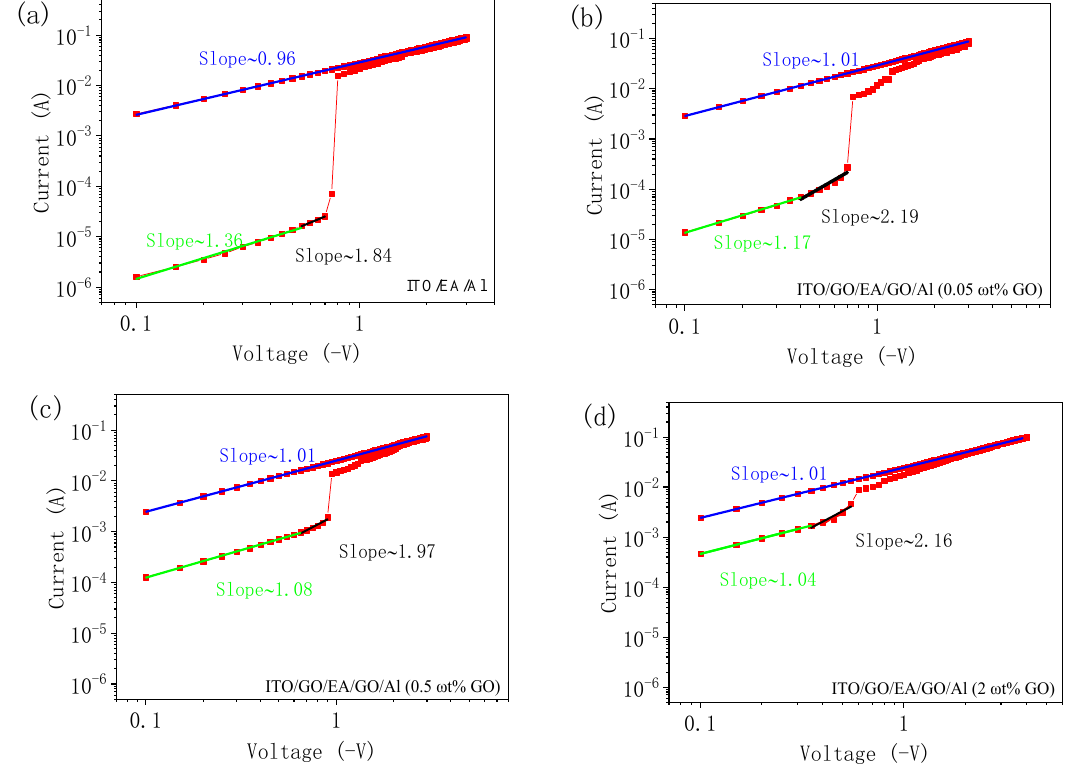
Figure 13. Cumulative probability of resistance for the ITO/EA/Al and ITO/GO/EA/GO/Al devices. The typical I-V characteristic curves in the negative bias region for all the devices were redrawn in log-log coordinates to analyse the carrier transport mechanism. A fitting analysis of the negative bias region for all the devices is shown in Figure 14. For the ITO/EA/Al device and the ITO/GO/EA/GO/Al devices with GO concentrations of 0.05 ωt%, 0.5 ωt%, and 2 ωt% in the GO layers, the fitted slopes of the I-V characteristic curves in the LRS are 0.96, 1.01, 1.01, and 1.01, which means that these devices exhibit ohmic behaviour in the conduction region. For the fitted I-V characteristic curves in the HRS when these devices are turned off, the slopes in the low voltage range are 1.36, 1.17, 1.08, and 1.04. The carrier conduction behaviour of the devices in this region still conforms to Ohm’s law. As the voltage increases, the fitted slopes gradually grow to 1.84, 2.19, 1.97, and 2.16. This process is consistent with the theory of the trap-controlled space charge current limiting mechanism [5].